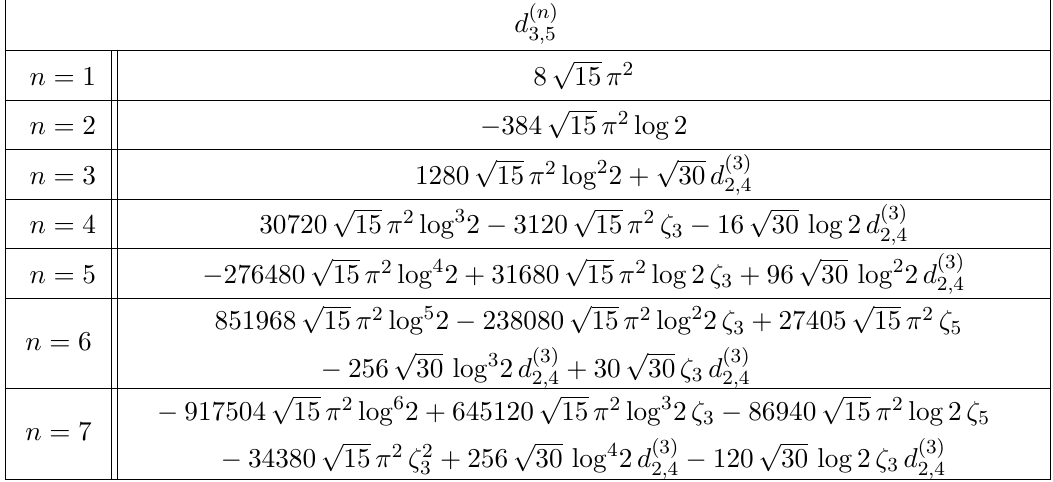
Table 3 . The first seven coefficients d ( n )